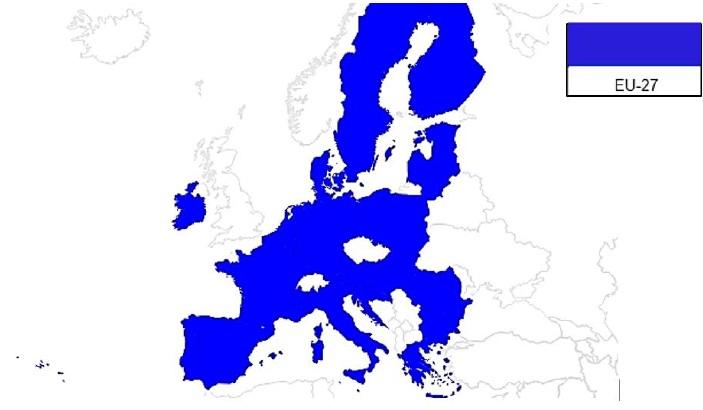
Figure 3. The Map of EU-27 Countries (own elaboration based on [67]).